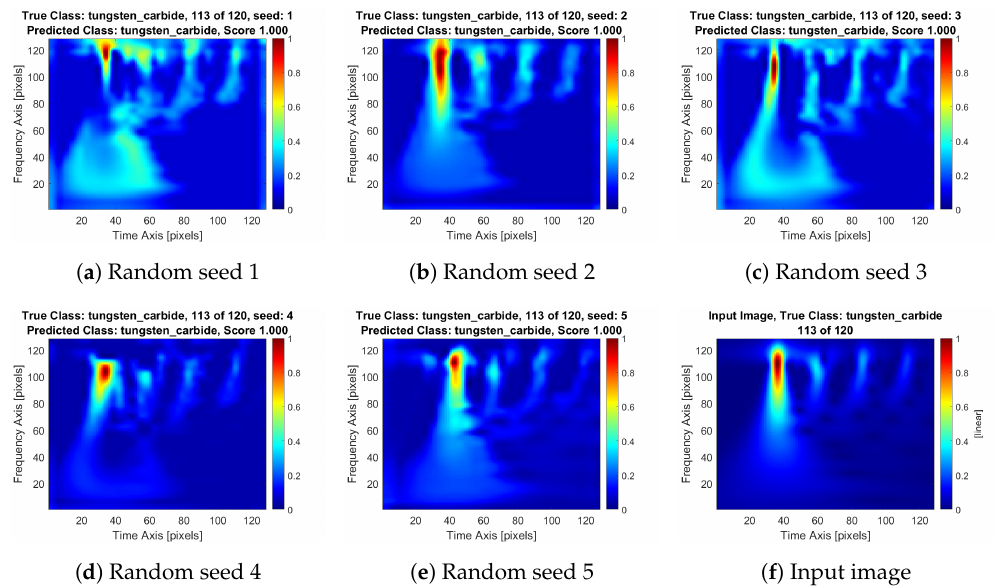
Figure 11. Grad-CAM heat maps for the CNN trained to classify the target material initialized using ( a – e ) random seeds 1–5, respectively. All seeds resulted in the correct classification of the ( f ) tungsten carbide input image. The classification scores are listed in the titles. All units are linear and have been normalized between 0 and